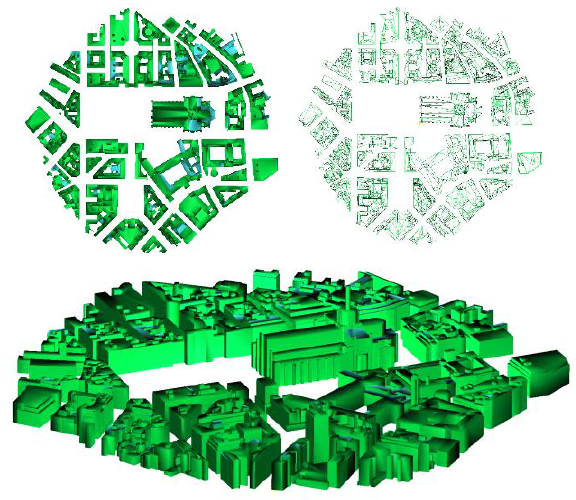
Figure 10. CityGML Model of Milan central